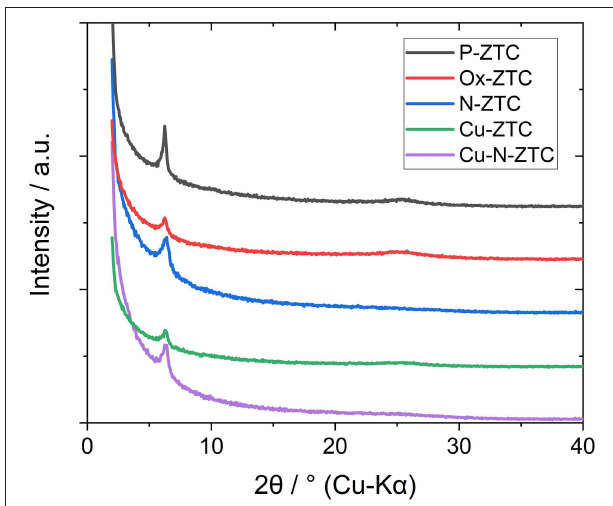
FIGURE 1 | XRD patterns of ZTC samples.